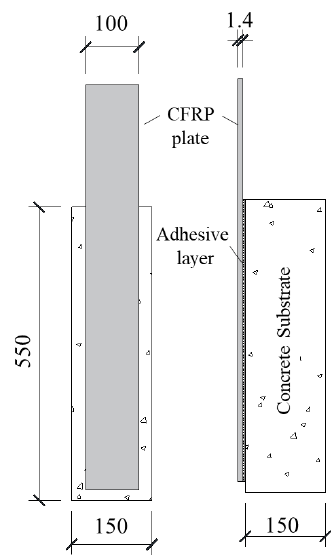
Figure 1. Loading configuration and specimen.